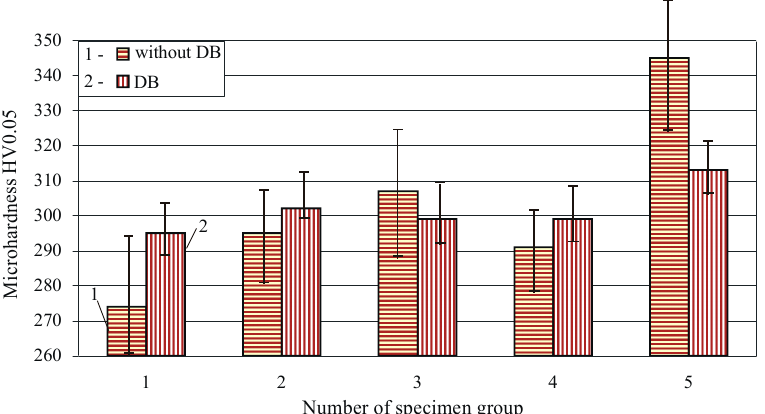
Figure 10. Effect of heat treatment and severe surface plastic deformation on the micro-microhardness of Cu-10Al-5Fe bronze: 1—as received, 2—annealed, 3—quenched, 4—quenched and tempered at 600 °C, 5—quenched and tempered at 300 °C.